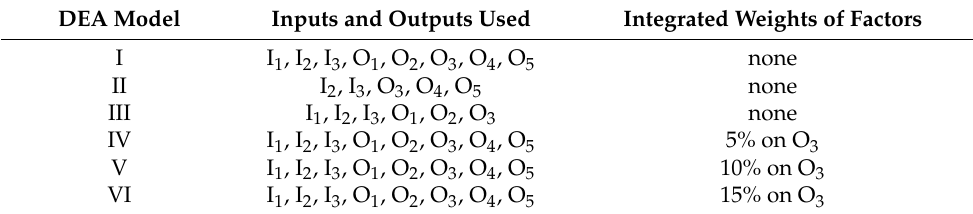
Table 5. Modifications for DEA Malmquist model for national governments and agencies.